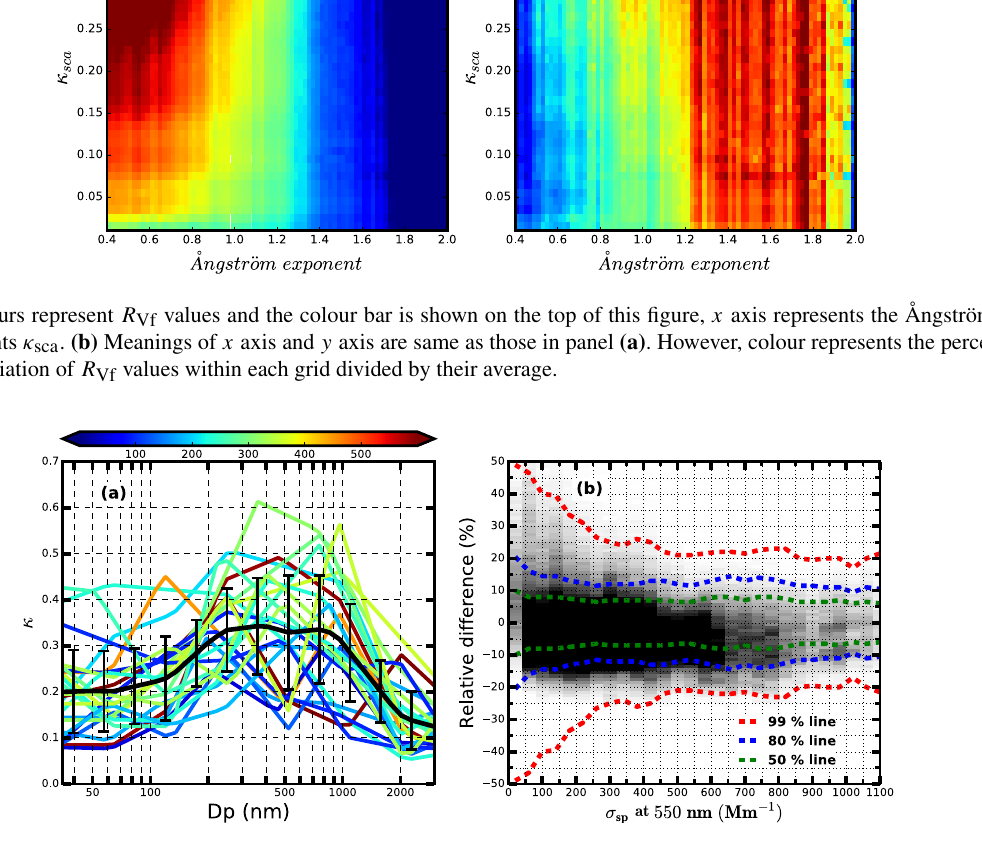
Figure 7. (a) All size-resolved κ distributions, which are derived from measured size-segregated chemical compositions during HaChi campaign, colours represent corresponding values of average σ sp at 550nm (Mm − 1 ), the black solid line is the average size-resolved κ distribution and error bars are standard deviations; (b) the grey colours represent the distribution of relative differences between modelled and estimated R Vf values, darker grids have higher frequency and dashed lines with the same colour mean that corresponding percentile of points locate between the two